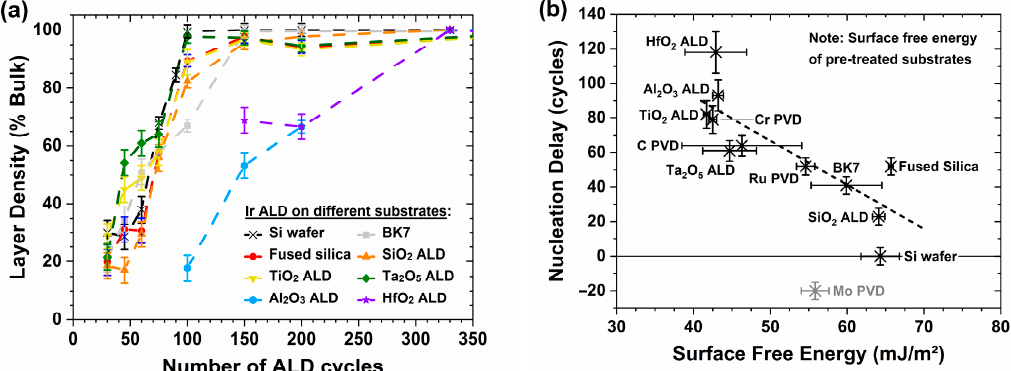
Figure 8. ( a ) Layer density of Ir coatings depending on the number of ALD cycles on different substrate materials increases strongly between 45 and 100 cycles, except on Al 2 O 3 and HfO 2 seed layers. ( b ) Iridium ND of thickness growth regime correlates with the surface free energy of the corresponding (pre-treated) substrate materials. The lower the wettability of the substrate, the higher the ND for the Ir ALD coating. This correlation persists for both the pre-treated and untreated substrate materials.